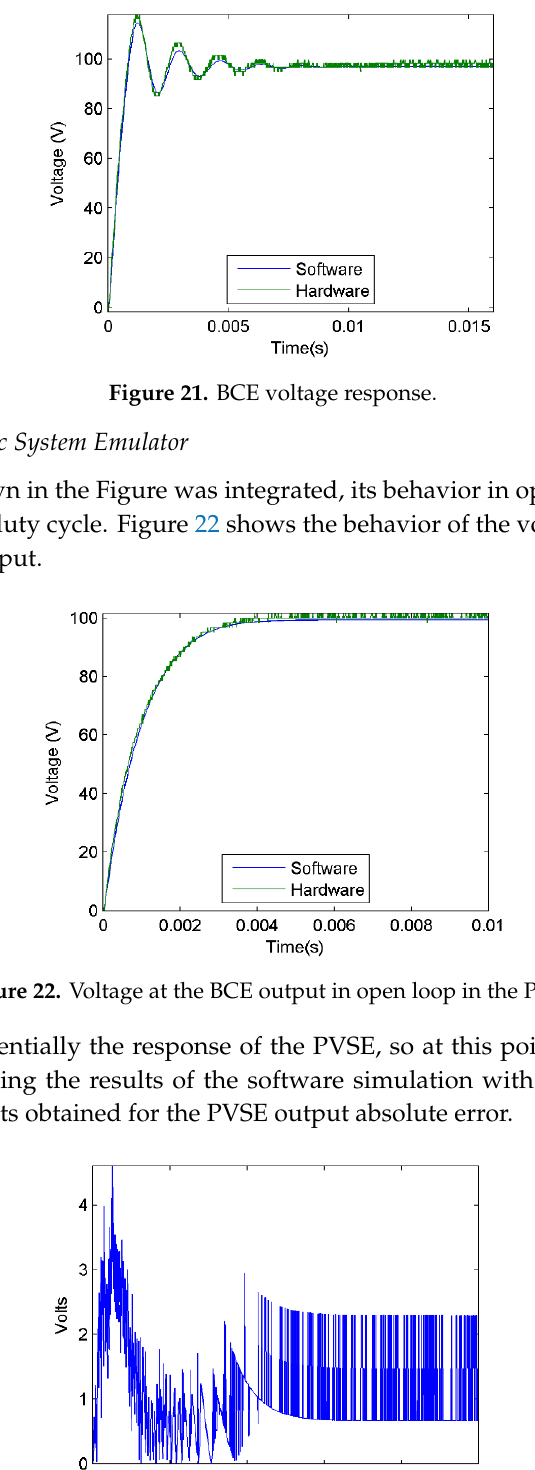
Figure 20. Current response from the boost convertor emulator (BCE).